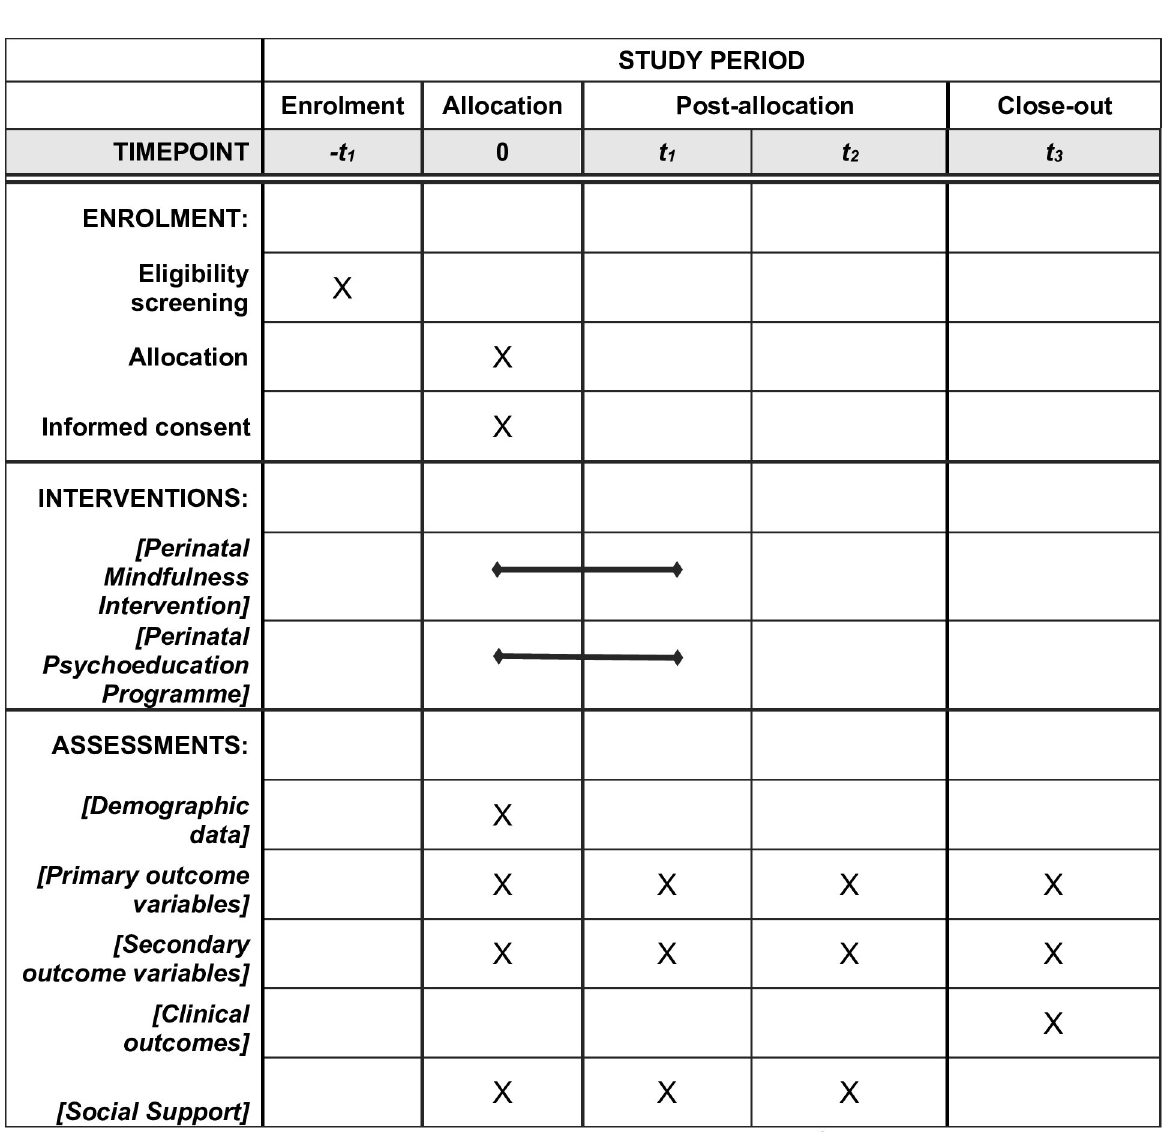
Fig 2. SPIRIT schedule of enrolment, intervention and assessments. Note: -t1, 0, baseline; t1, post 8-week intervention; t2, 36-week gestation follow up; t3. 5-week postpartum follow up.